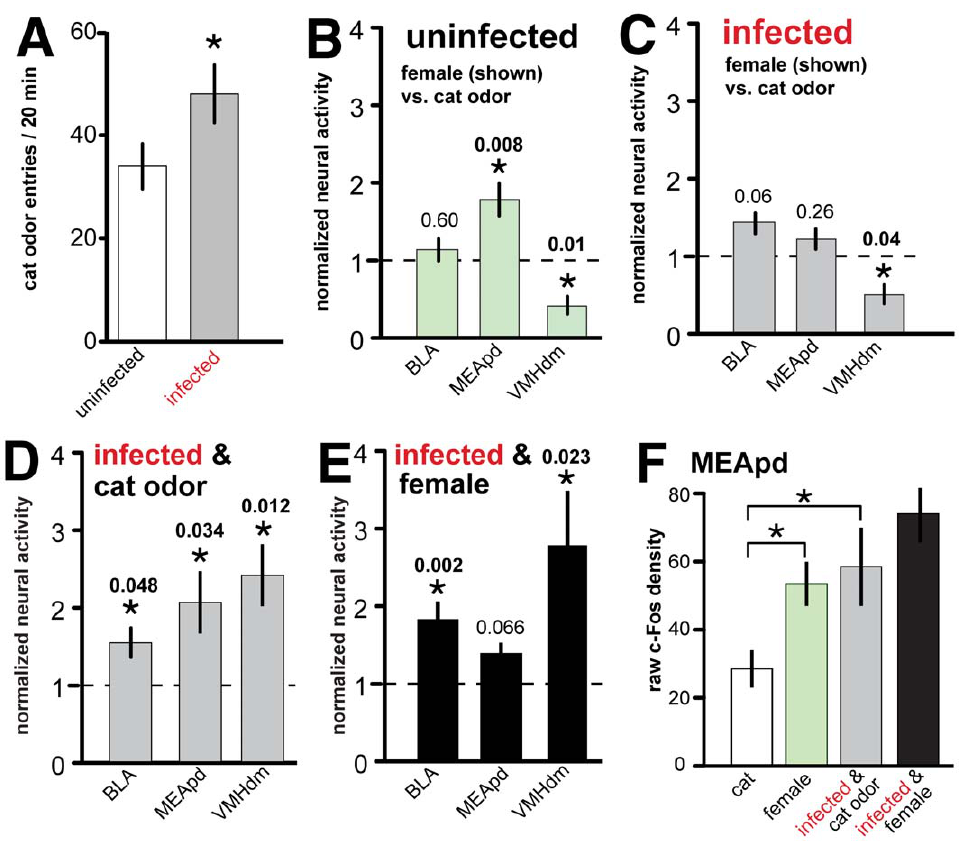
Figure 1. Toxoplasma Infection Alters the Limbic Response in Rats Exposed to Cat Odor. (A) Toxoplasma infected rats spent more time exploring cat urine than uninfected rats. (B) In uninfected animals, female odor induces relatively greater ‘reproductive’ MEApd activity and relatively diminished ‘defensive’ VMHdm activity, as expected. (C) In infected animals, activity levels in the MEApd are the same, regardless of whether exposed to a ‘reproductive’ or ‘defensive’ odor. (D) Neural activity in infected male rats, normalized to uninfected controls, after exposure to cat urine. Infection increased neural activity in the BLA, MEApd and VMHdm. (E) Neural activity in infected male rats, normalized to uninfected controls, after exposure to an estrous female. Infection again increased neural activity in the BLA and VMHdm, but did not change MEApd levels. (F) Toxoplasma infection increased ‘reproductive’ MEApd neural activity during exposure to cat odor, mimicking neural activity in uninfected animals exposed to a female rat. MEApd , posterodorsal medial amygdala; VMHdm , ventromedial hypothalamus, dorsomedial part; BLA , basolateral amygdala. P values listed where appropriate.